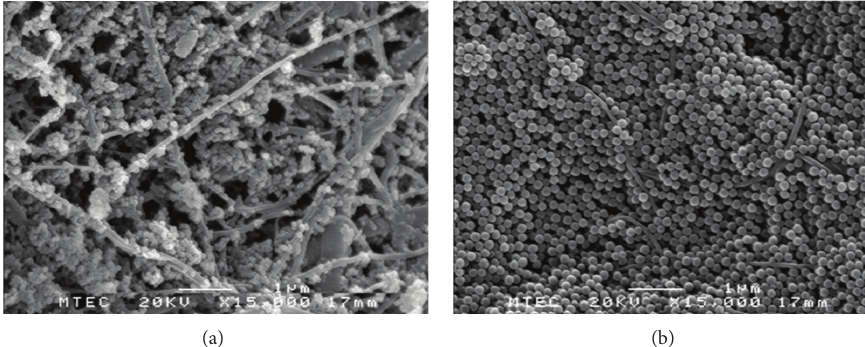
Figure 9: SEM images of polystyrene particles with different diameters, (a) 90nm and (b) 200nm, on the filter fronts.